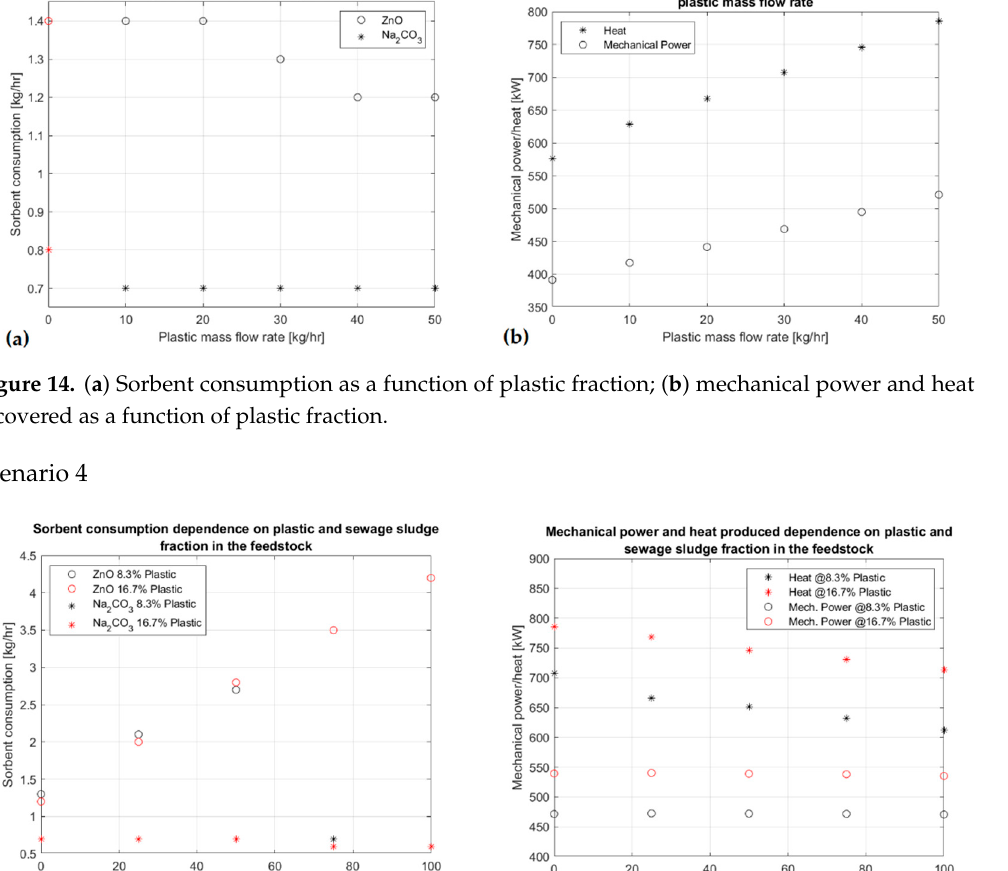
Figure 13. ( a ) H 2 and CO molar fractions as a function of plastic fraction and gasification ER; ( b ) Mechanical power and combustion temperature as a function of the plastic fraction and combustion ER.